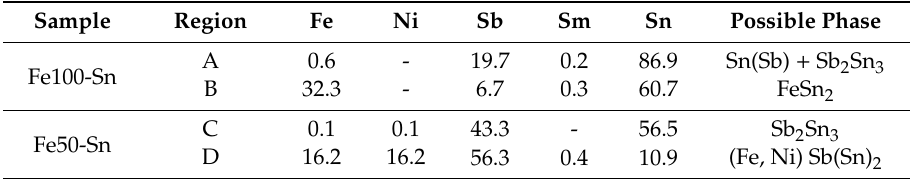
Table 4. EDS chemical analysis (at. %) of di ff erent regions identified in the wetting samples tested with Sn and indicated in Figure 9 (regions A and B) and 10 (regions C and D); at least five spots were analyzed for each